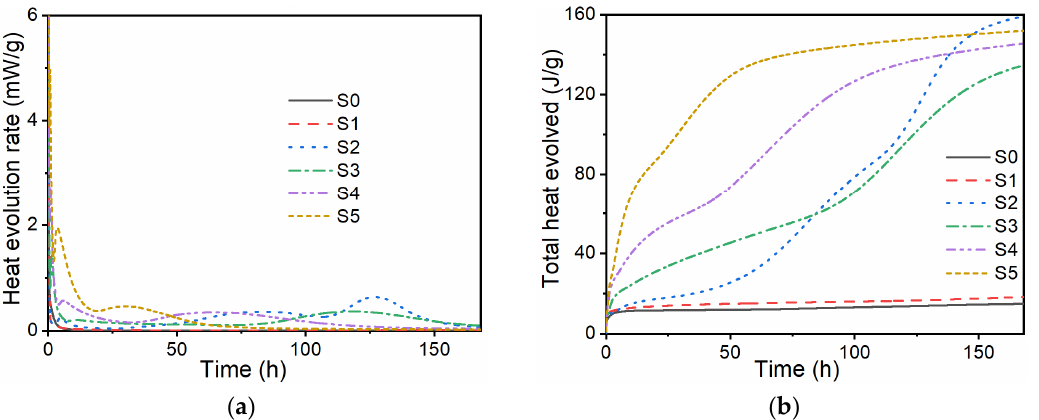
Figure 1. ( a ) Heat evolution rate and ( b ) total heat evolved from the mixtures during the first 168 h of